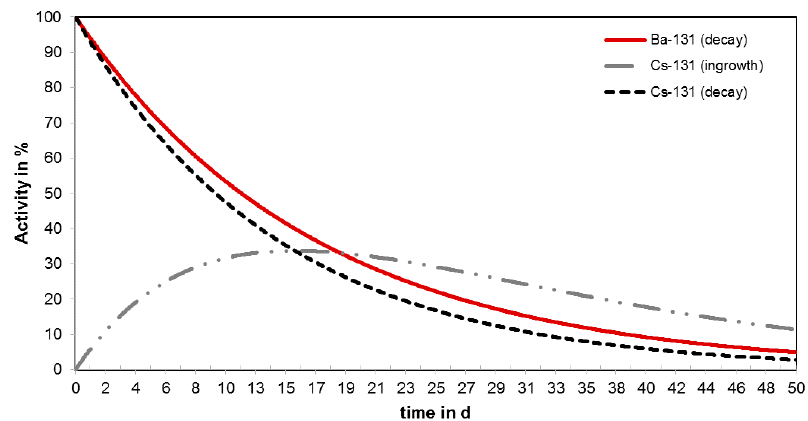
Figure 11. Calculated decay scheme of barium-131 and cesium-131.